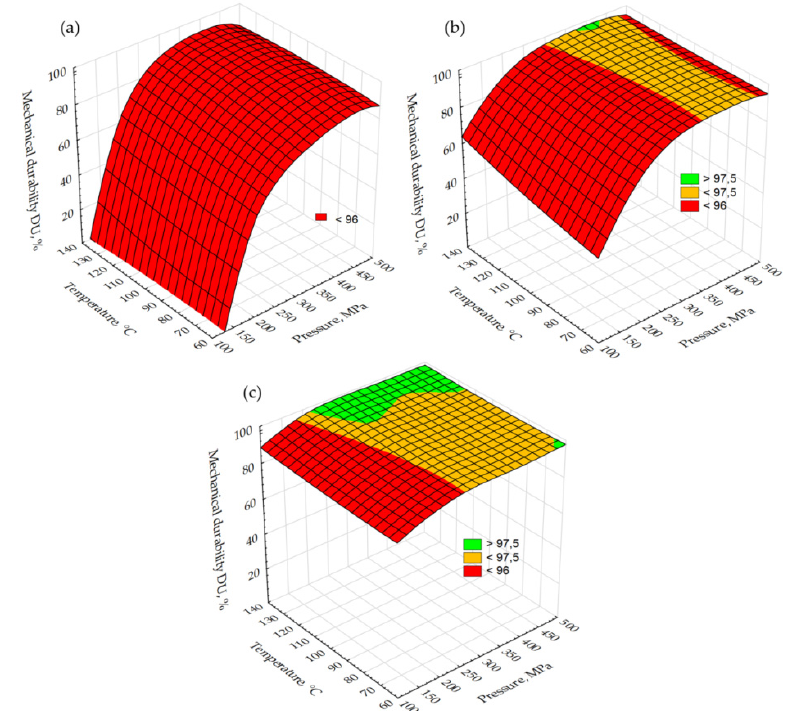
Figure 3. Changes of test pellet mechanical durability DU due to the temperature of drying and compaction pressure: ( a ) dry sample, ( b ) moisture content at a level of 5%, and ( c ) moisture content at a level of 10%.